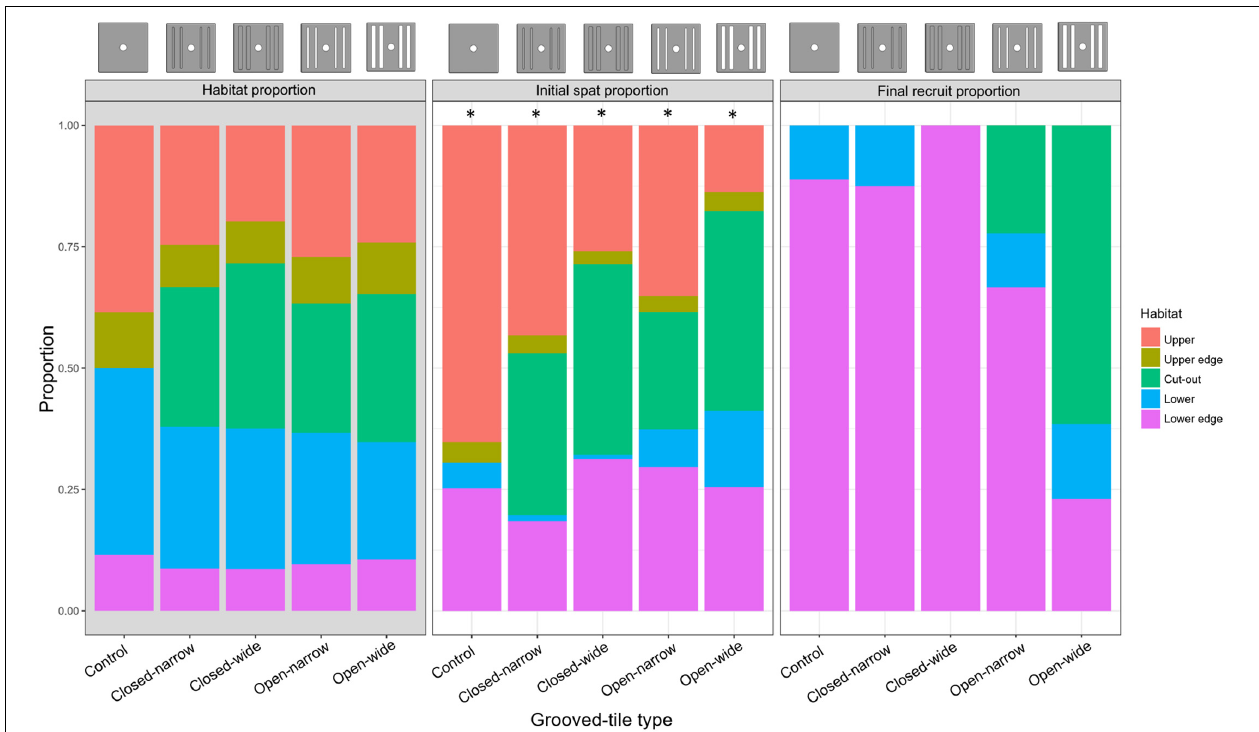
FIGURE 7 | Proportion of space available within each habitat type (‘Habitat proportion’), the proportion of live Acropora tenuis spat within each habitat type immediately after settlement (‘Initial spat proportion’), and the proportion of live A. tenuis juveniles approximately 1 year post-deployment (‘Final recruit proportion’) on five types of grooved-tiles. Note that the control devices did not have any grooves. Reference diagrams of each device type are included above the plots. Asterisks in the ‘Initial spat proportion’ data indicate statistically significant differences in the observed and expected settlement proportions based on a Chi-square goodness-of-fit test ( p < 0.05), but we stress that access to the ‘lower’ habitat by the larvae was at least partially